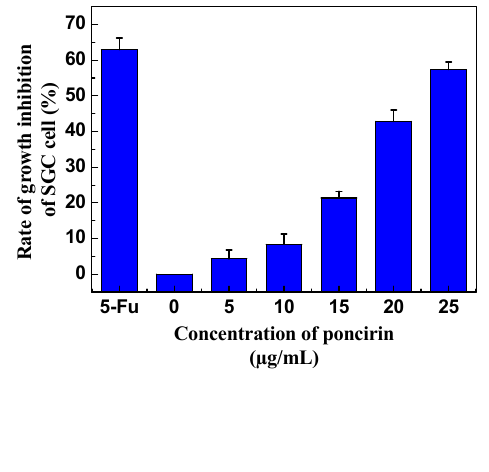
Figure 5. Inhibitory activity of purified poncirin on the growth of gastric cancer SGC-7901 cells. 5-Fu (positive control), 5-fluorouracil; Results are presented as mean ± S.D. ( n =